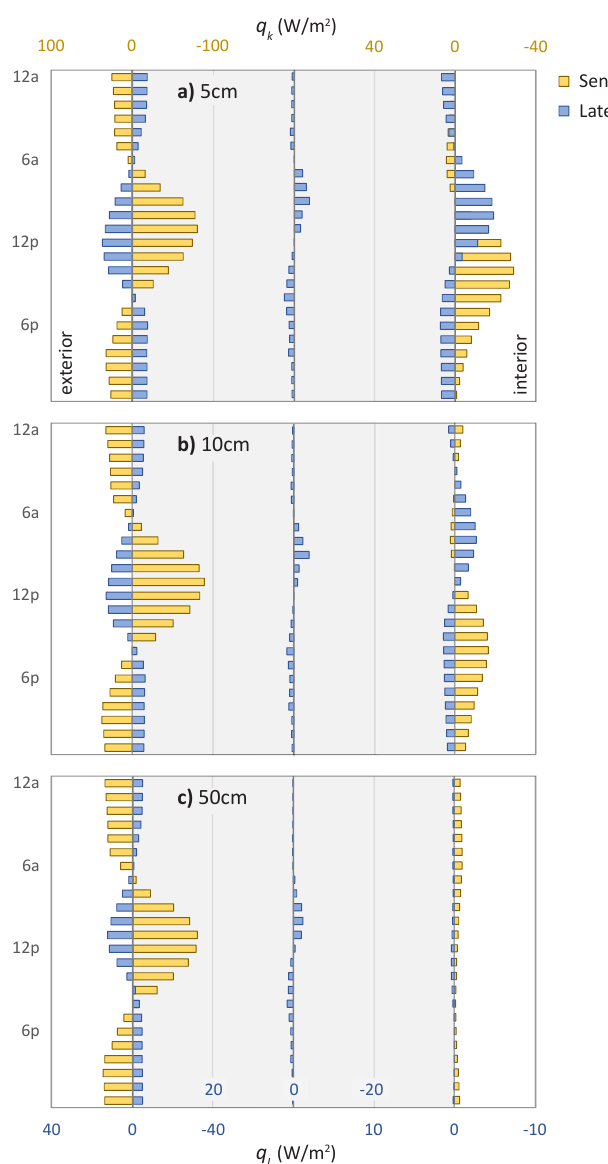
Figure 10. Effect of varying thickness on latent (blue) and sensible (yellow) heat fluxes across exterior and interior surfaces of ( a ) 5cm; ( b ) 10cm; and ( c ) 50cm cob walls, as well as evaporation and condensation within each wall itself, illustrating relative contributions of intrinsic evaporative cooling and thermal mass effects to the delay of heat delivery to interior spaces; note the respective scales. Data show average hourly July values in the west coast marine climate of Nantes, France (Köppen Cfb , Table 3, Figure 9) for south-facing walls of a well-characterized cob [48,49]; ambient humidity was the only source of